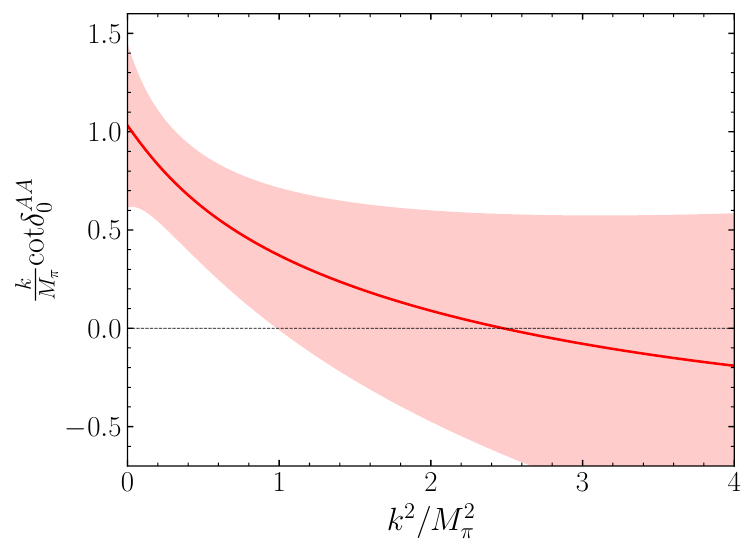
Figure 14 . s -wave phase shift for the AA channel in U(4) ChPT for ξ = 0 . 1 and N c = 3 , computed using the inverse amplitude method. We have set the LECs which are not proportional to momenta in eqs. (A.5) and (A.11) to the fitted values, and restricted the rest to be of the same order, as explained in the main text. We observe that the curve may change sign, indicating the possible existence of a tetraquark